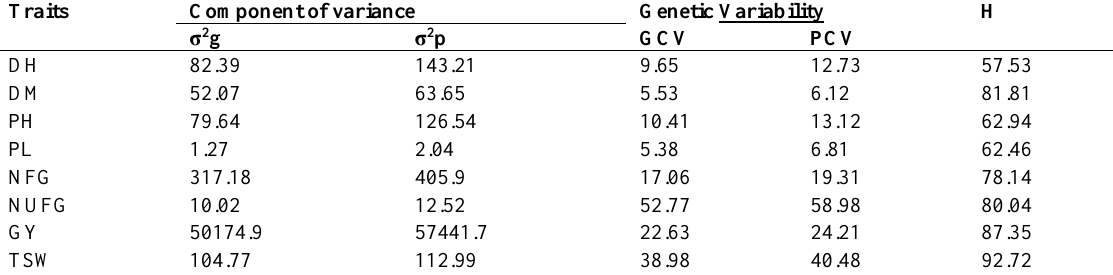
Table 3. Analysis of variance, performance means, components of variance, genetic variability, and heritability estimate for eight quantitative traits collected from 97 upland rice genotypes. Traits Component of variance Genetic